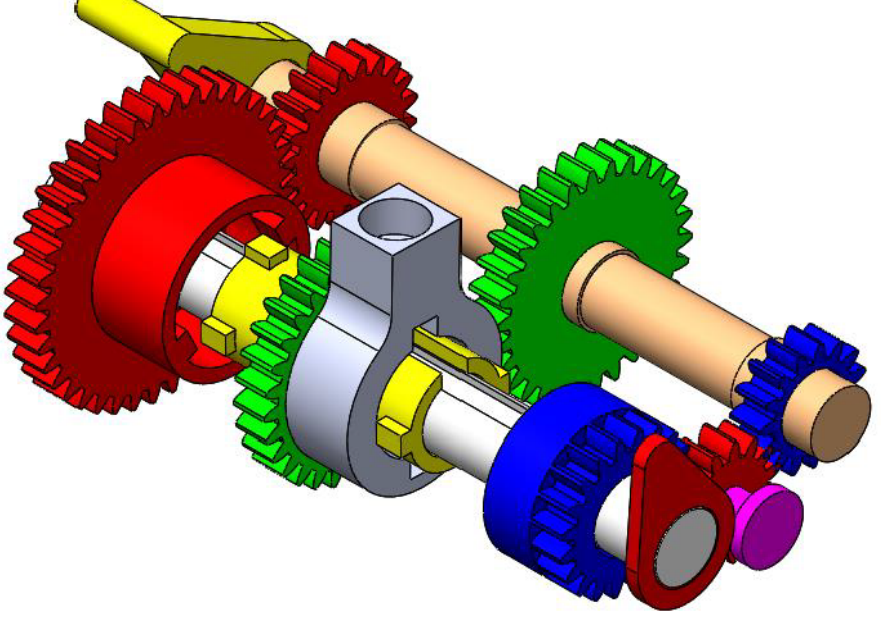
Figure 6. CAD model of a three-speed gearbox at University of Ferrara [38].